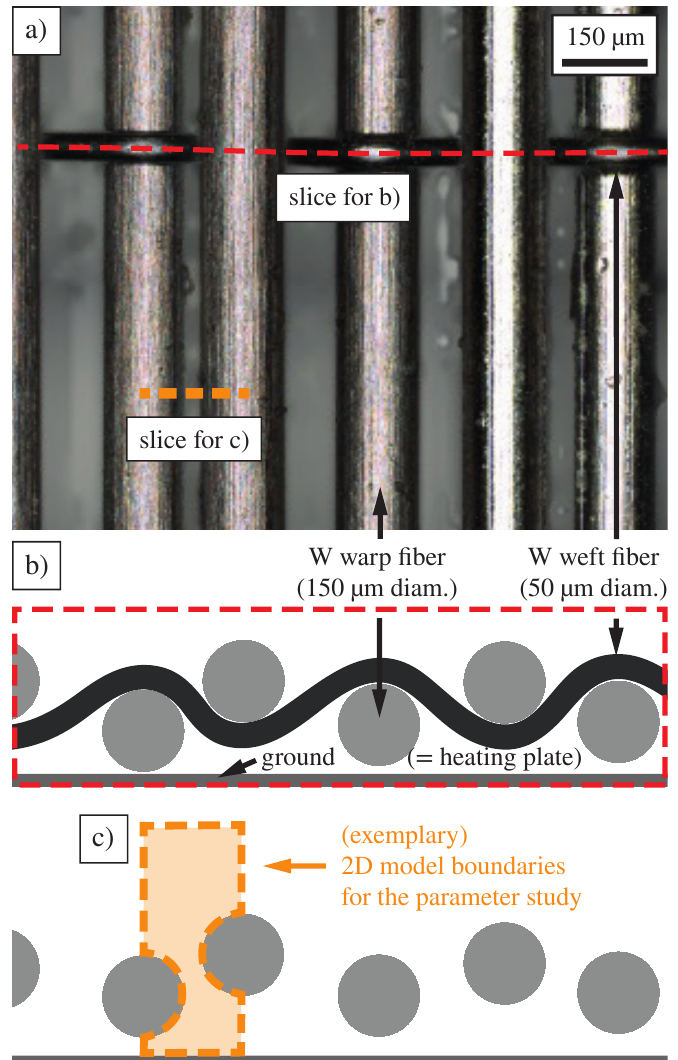
Figure 3. ( a ) Close-up of an uncoated W fabric showing a weft and several warp fibers. ( b , c ) Sketches for cross-sectional slices perpendicular to the warp fiber axes. The micro-scale model boundary was added to ( c